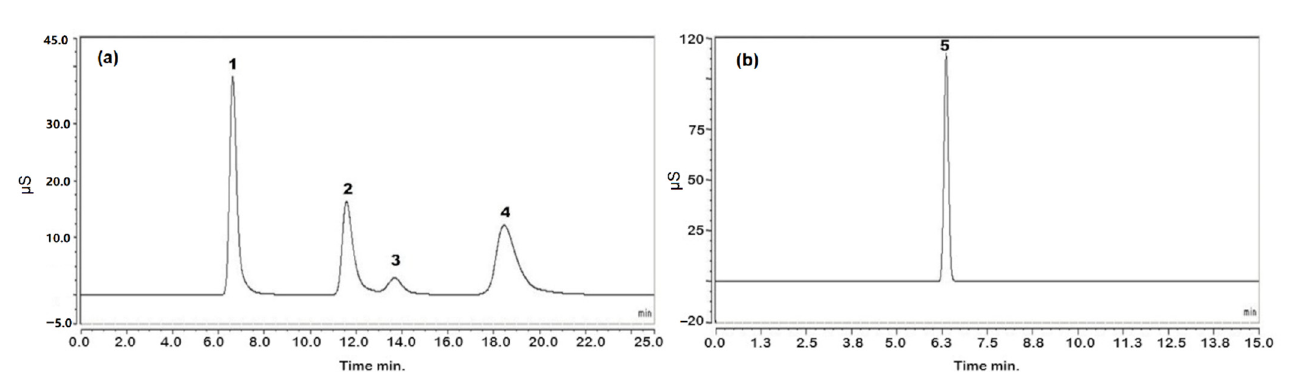
Figure 6. Chromatograms obtained using the optimized conditions (see Section 3.3) for analysis of PN solution: ( a ) chromatogram of cations; ( b ) chromatogram of anions. Peak 1: sodium, peak 2: potassium, peak 3: magnesium, peak 4: calcium and peak 5: chloride.